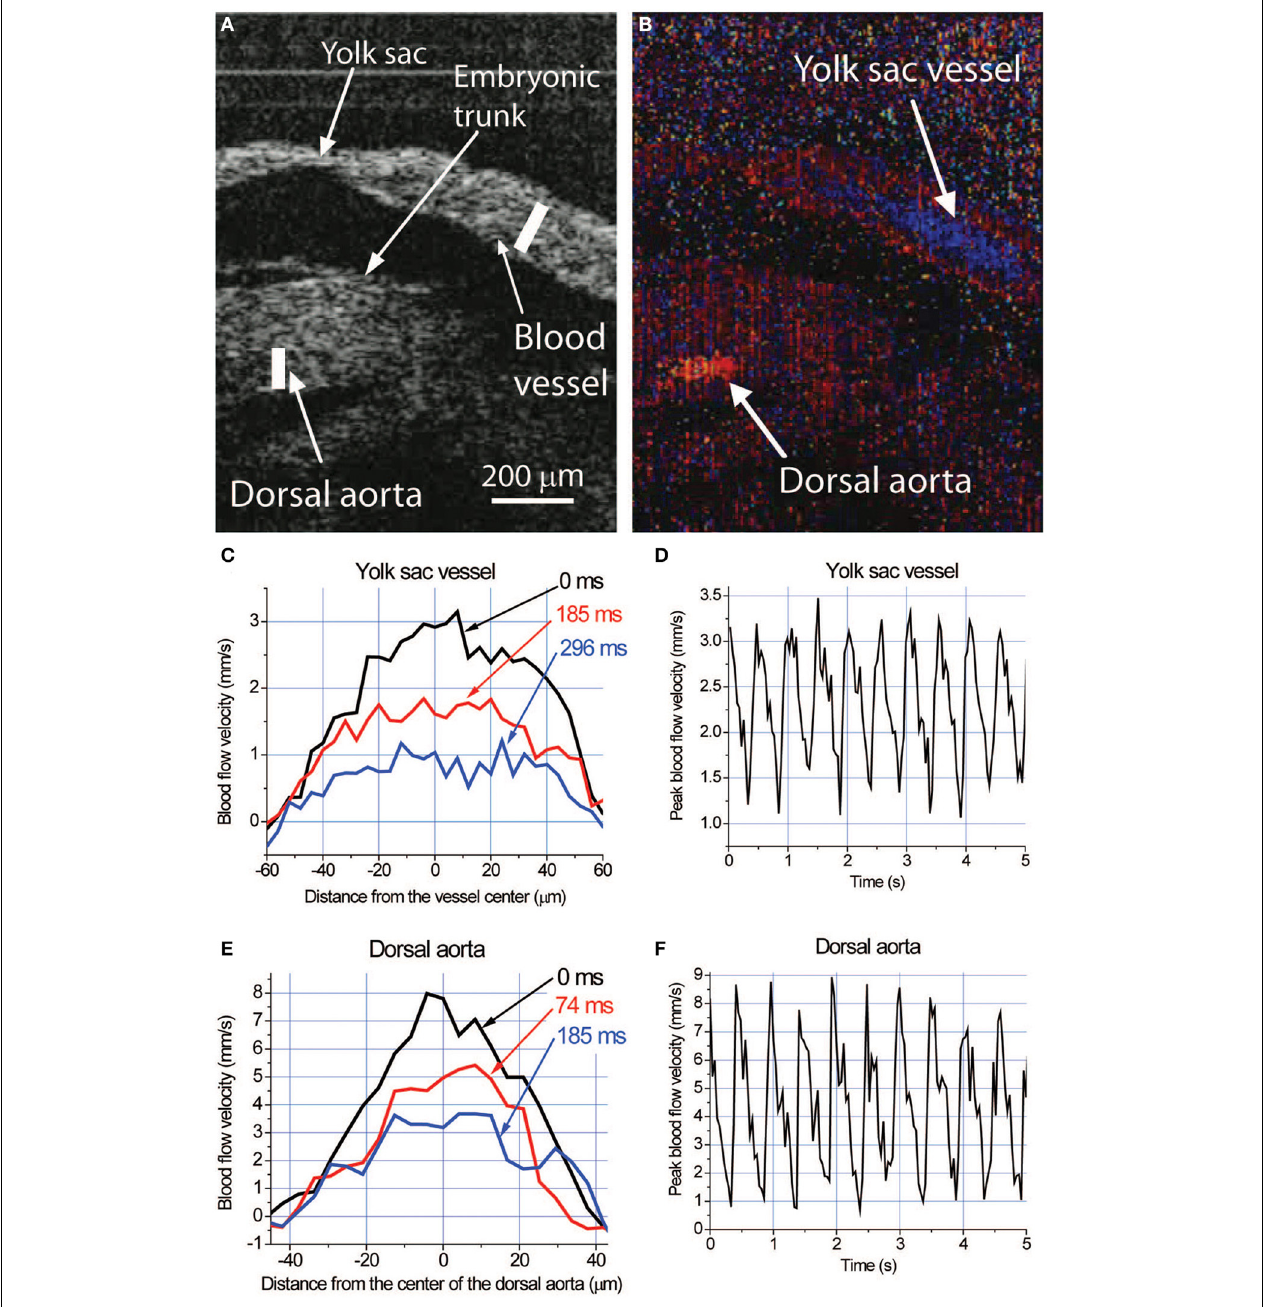
FIGURE 4 | Live hemodynamic analysis with Doppler OCT in cultured mouse embryos at E9.5. (A) Structural image of an E9.5 embryo showing fragments of the yolk sac and embryonic trunk. (B) Corresponding color-coded Doppler OCT image showing strong signals produced by blood flow in the yolk sac vessel and dorsal